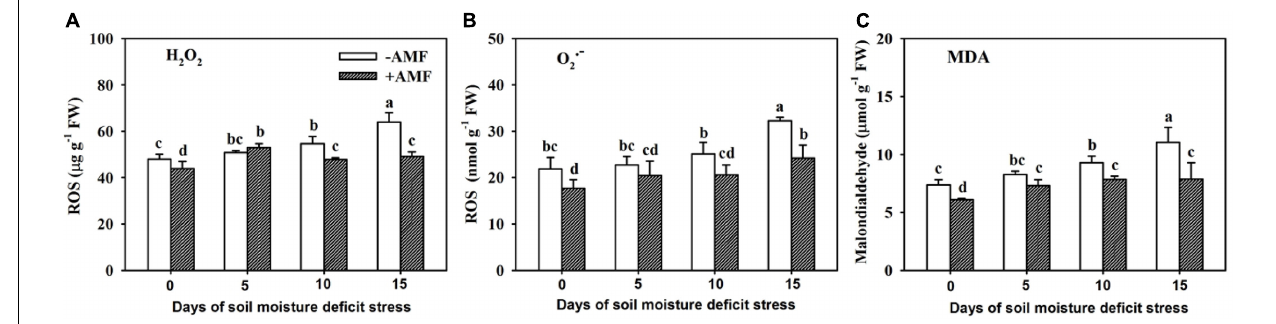
FIGURE 8 | Contents of root hydrogen peroxide (H 2 O 2 ) (A) , superoxide anion free radical (O 2 - ) (B) , and malondialdehyde (MDA) (C) of trifoliate orange seedlings inoculated with and without Funneliformis mosseae during exposure to soil moisture deficit stress of 0-15 days. Data (mean ± SD, n = 4) followed by different letters above the bars indicate significant ( P < 0.05)